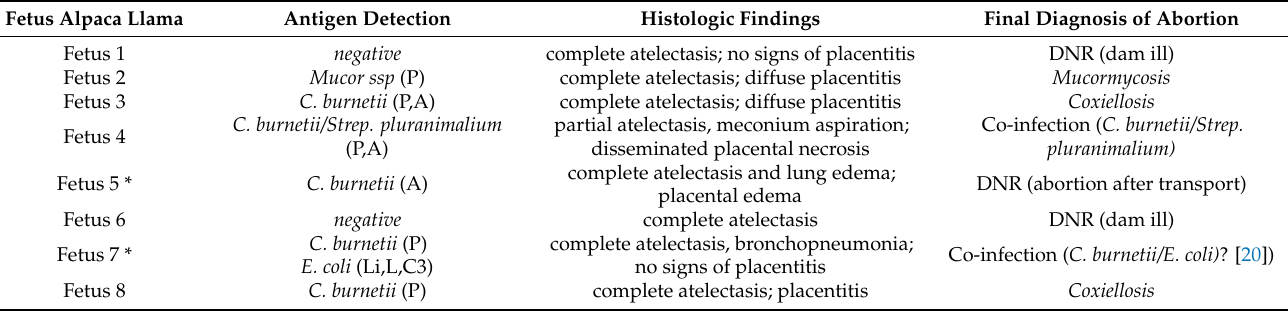
Table 2. Pathogen antigen and antibody detection and histologic findings in 8 cases of abortion or stillbirth in 7 Swiss South American camelid